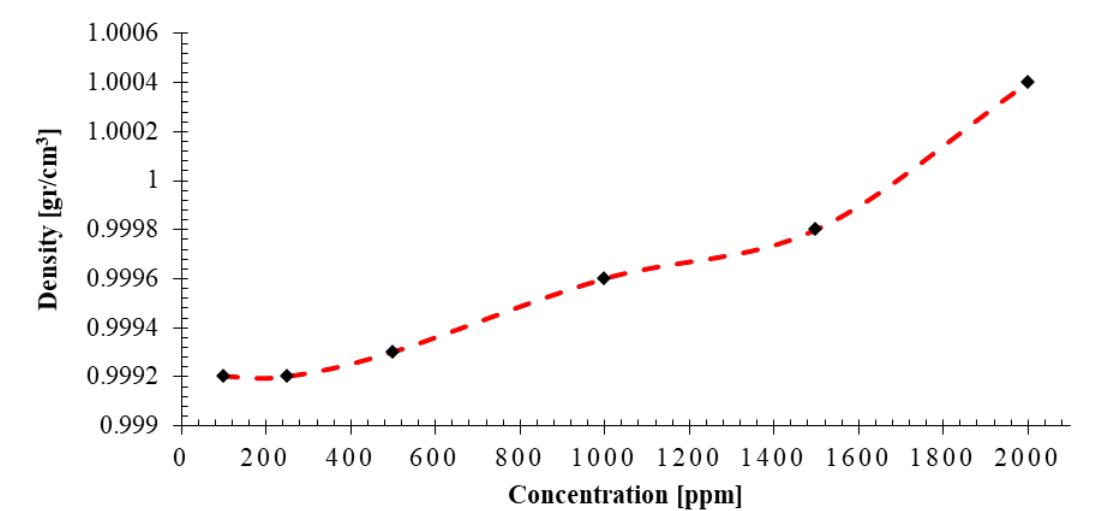
Figure 9. pH values determined for the nanofluids prepared using different concentrations of the novel NC (100–2000 ppm). pH of the prepared nanofluids is almost insensitive to changes in concentration of the novel NC.